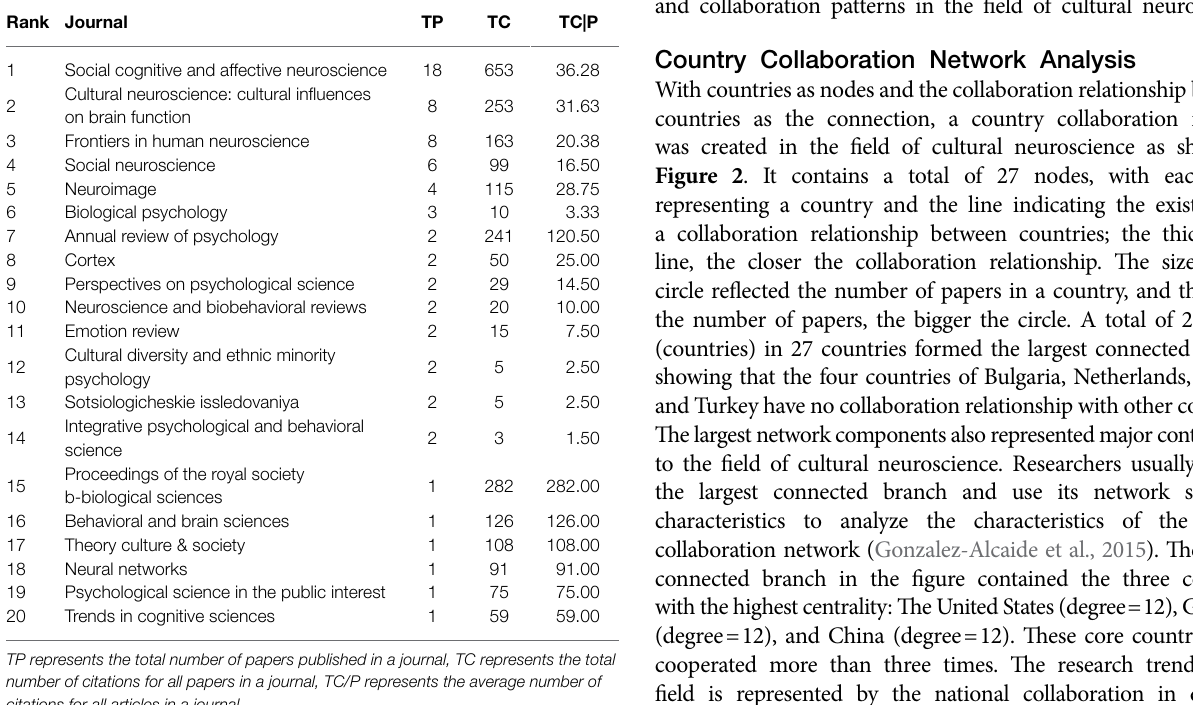
TABLE 6 | Top 20 most influential journals.